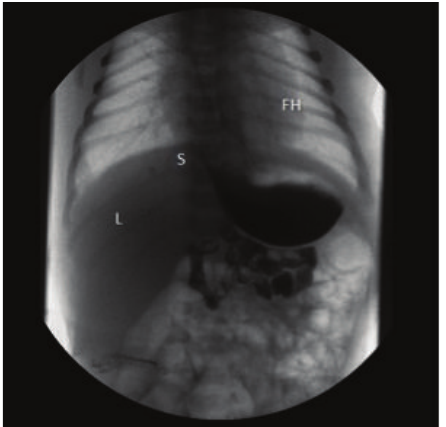
Figure 3: The anteroposterior image of the upper gastrointestinal tract series using barium demonstrating that the stomach (S) was above the diaphragm. FH: fetal heart; L: